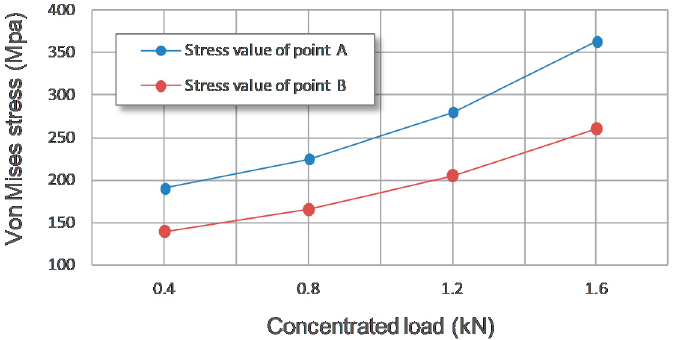
Figure 16. Stress magnitude at point A (the maximum stress value around the center SiC fiber in the first row) and point B (the maximum stress value around the center SiC fiber in the second row) for the four stress fields with increasing